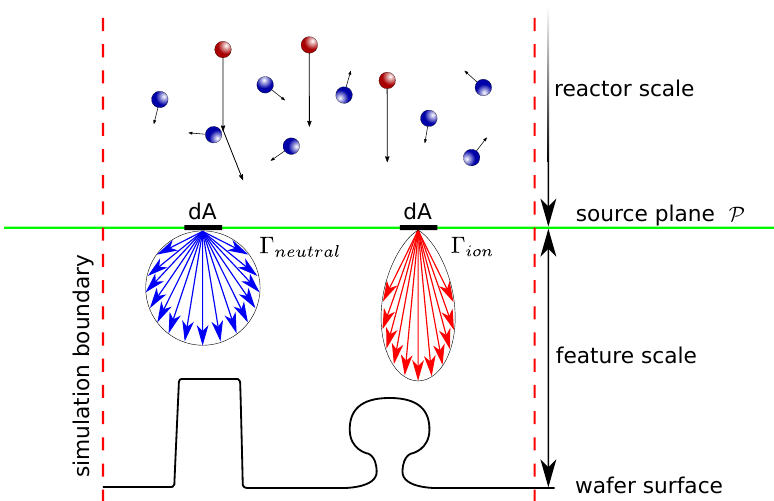
Figure 6. Schematic representation of the traversal of neutral molecular entities and ions through the reactor and feature scale regions. While the motion through the reactor scale is dominated by random collisions with other molecular entities, the path through the feature scale region is dominated by ballistic transport. The directional distribution of neutral atoms and molecules Γ neutral (blue) and ions Γ ion (red) entering the feature scale region is shown as blue and red arrows, respectively. The molecular entities will then traverse the feature scale region in straight lines, only colliding with the